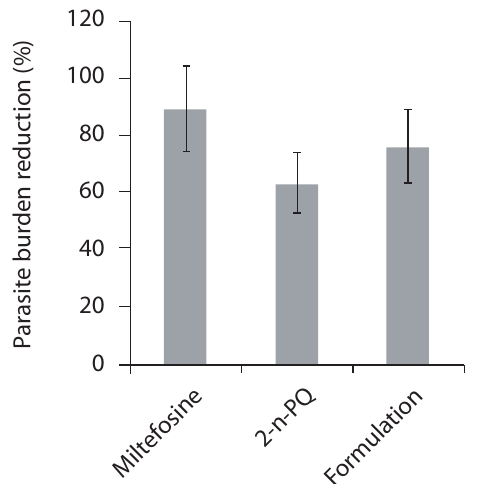
Fig. 5. – In vivo antileishmanial activity of the 2-n-propylquinoline camphorsulfonic salt vs 2-n-propylquinoline (2-n-PQ) vs miltefosine on the L. donovani / Balb/c mice model. - Miltefosine vs 2-n-PQ: no significant (P > 0.05). - 2-n-PQ vs formulation: no significant (P > 0.05). - Miltefosine vs formulation: no significant (P >